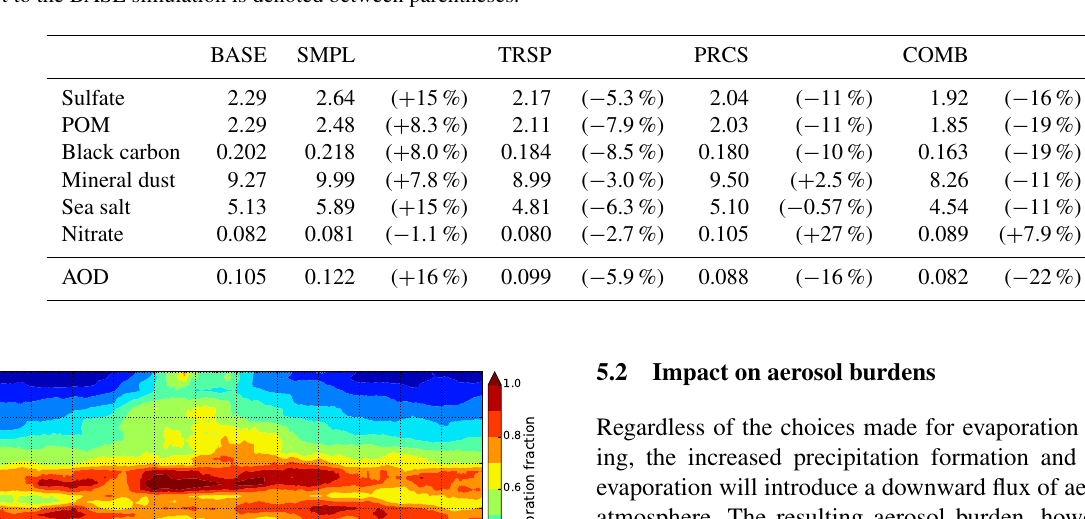
Table 3. Annual average global atmospheric burdens (Tg) of the individual aerosol species and global average AOD. Relative change with respect to the BASE simulation is denoted between parentheses.